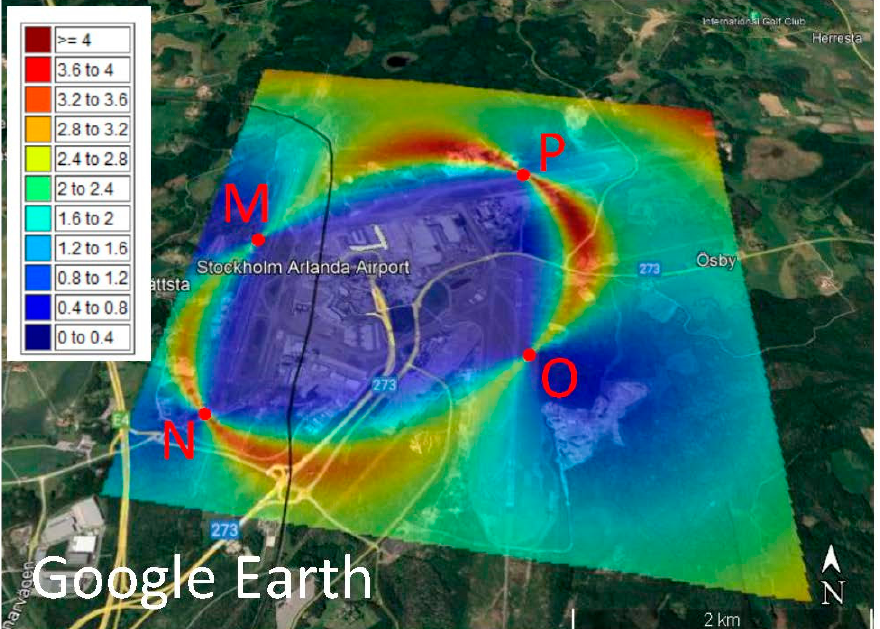
Figure 4. Dilution of precision (DOP) of the optimal design of a security localisation network with the DOP criterion based on the received signal strength differences (RSSD) over the Google Earth map of the Arlanda international airport.